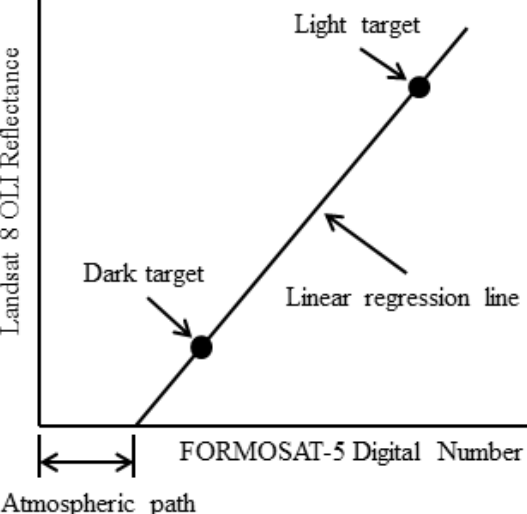
Figure 4. Explanation of the use of the linear regression model for converting a DN to Rrs.